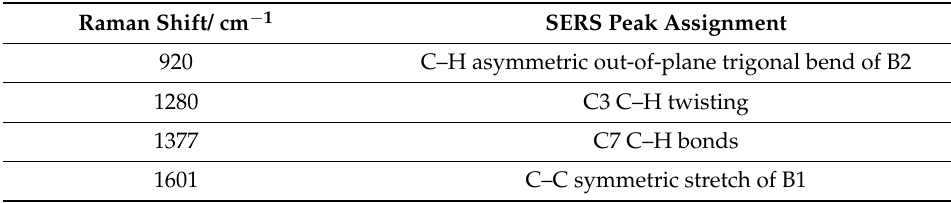
Figure 2. ( a ) SERS spectra of artificially contaminated tap water with fentanyl concentrations from 0 ppt to 1 ppm; ( b ) the intensity of the representative peak at 1377 cm –1 with respect to fentanyl concentrations; ( c ) the plot of PCA results for all measured SERS spectra; and ( d ) the PLSR analysis results. Table 2. Raman shift assignment of the fentanyl SERS spectra.